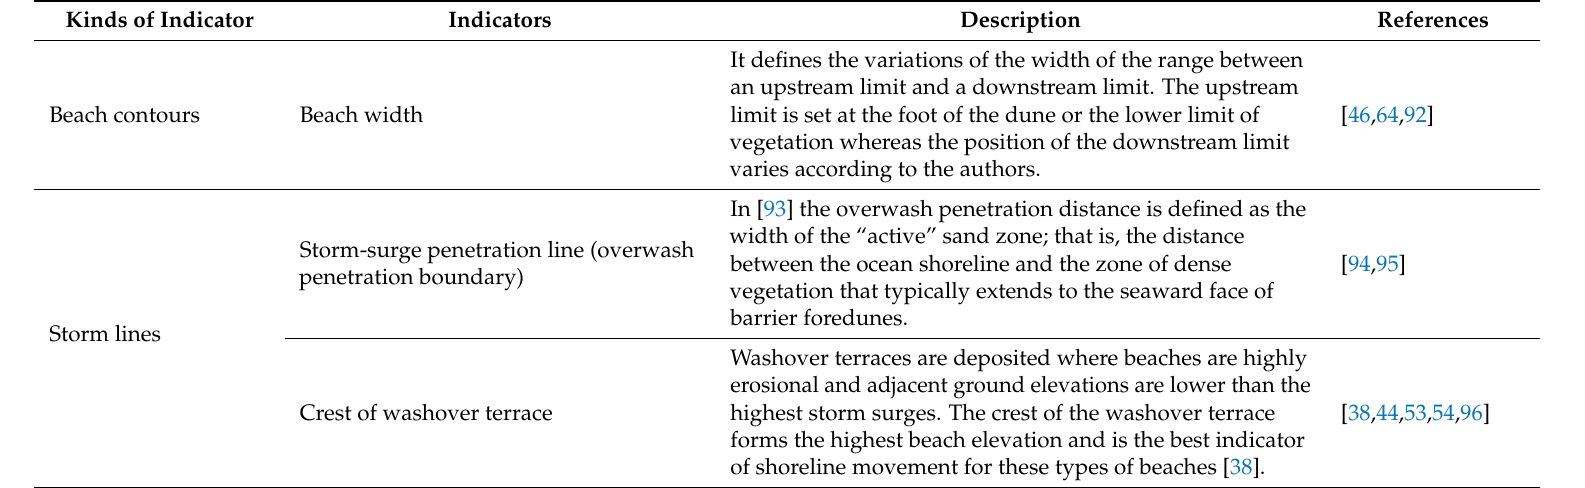
Table 5. Summary of shoreline indicators (adapted from [8,9]